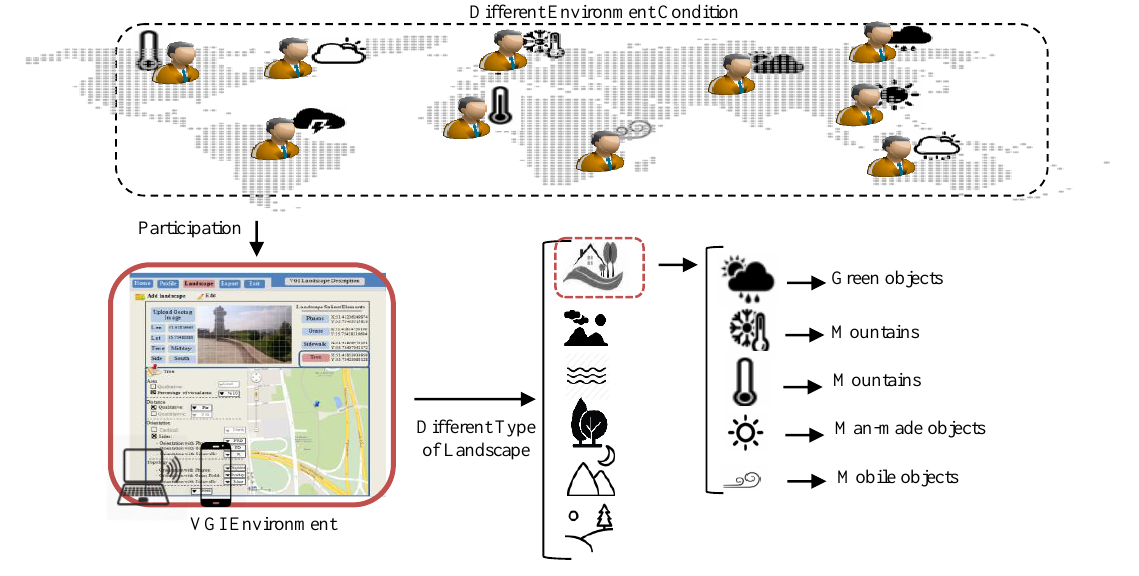
Figure 3. The approach